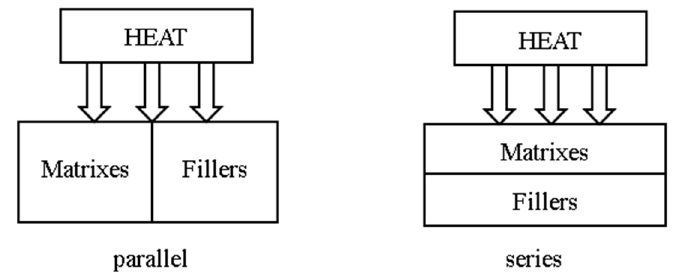
Figure 22. Parallel and series models.